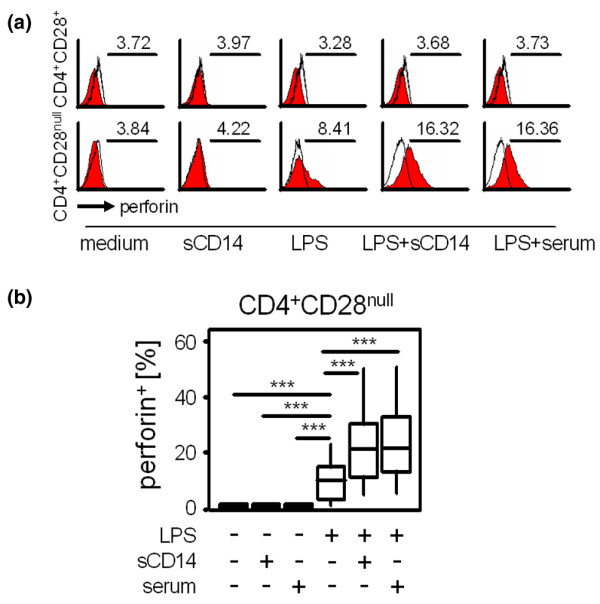
Effects of LPS, sCD14 and autologous serum on perforin production by CD4+ T cells. Fresh peripheral blood mononuclear cells of patients with ankylosing spondylitis were incubated with medium (as a negative control), soluble CD14 (sCD14) or 10 μg/ml lipopolysaccharide (LPS) alone or with LPS in combination with 25 μg/ml sCD14 and 5% autologous serum for 16 hours. After staining with fluorescence-marked monoclonal antibodies directed against perforin, CD4 and CD28, cells were counted by flow cytometry. (a) Histograms show perforin production by CD4+CD28+ (upper row) and CD4+CD28null T cells (lower row) in response to medium, sCD14, LPS, LPS + sCD14 and LPS + serum as indicated (red curves). Black lines represent isotype control staining. Values indicate the mean fluorescence intensity. Gates for CD4+CD28null and CD4+CD28+ T cells were set as shown in Figure 3a. (b) Box blots show percentages of perforin-producing CD4+CD28null T cells from seven independent experiments. Differences were tested for significance using the Wilcoxon test. ***P ≤ 0.001.